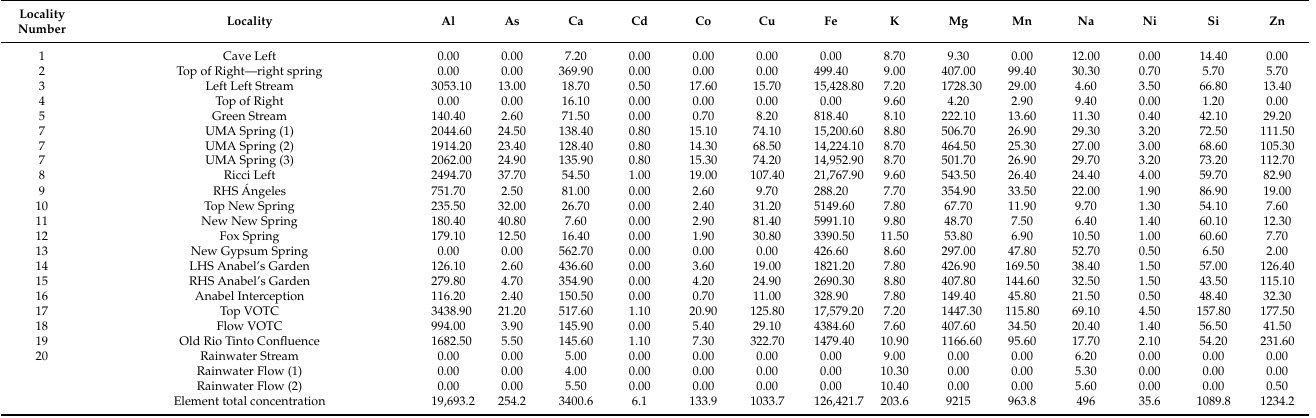
Table 4. Element list of cations (mg · L − 1 ) obtained through ICP (Induced Couple Plasma) geochemical analysis. Locality